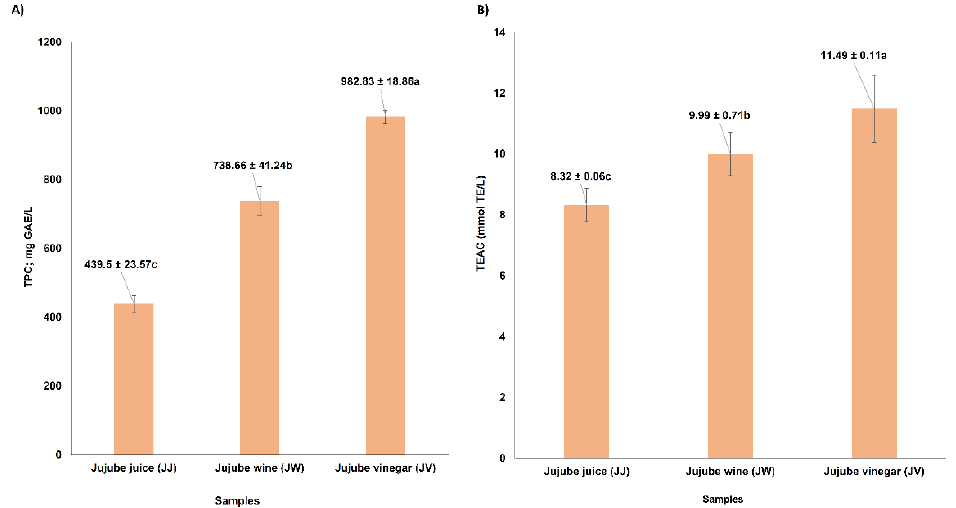
Figure 3. Total phenolic substance ( A ); and antioxidant activity ( B ) of jujube juice (JJ), jujube wine (JW) and jujube vinegar (JV). Different letters in the figure indicate significant differences between